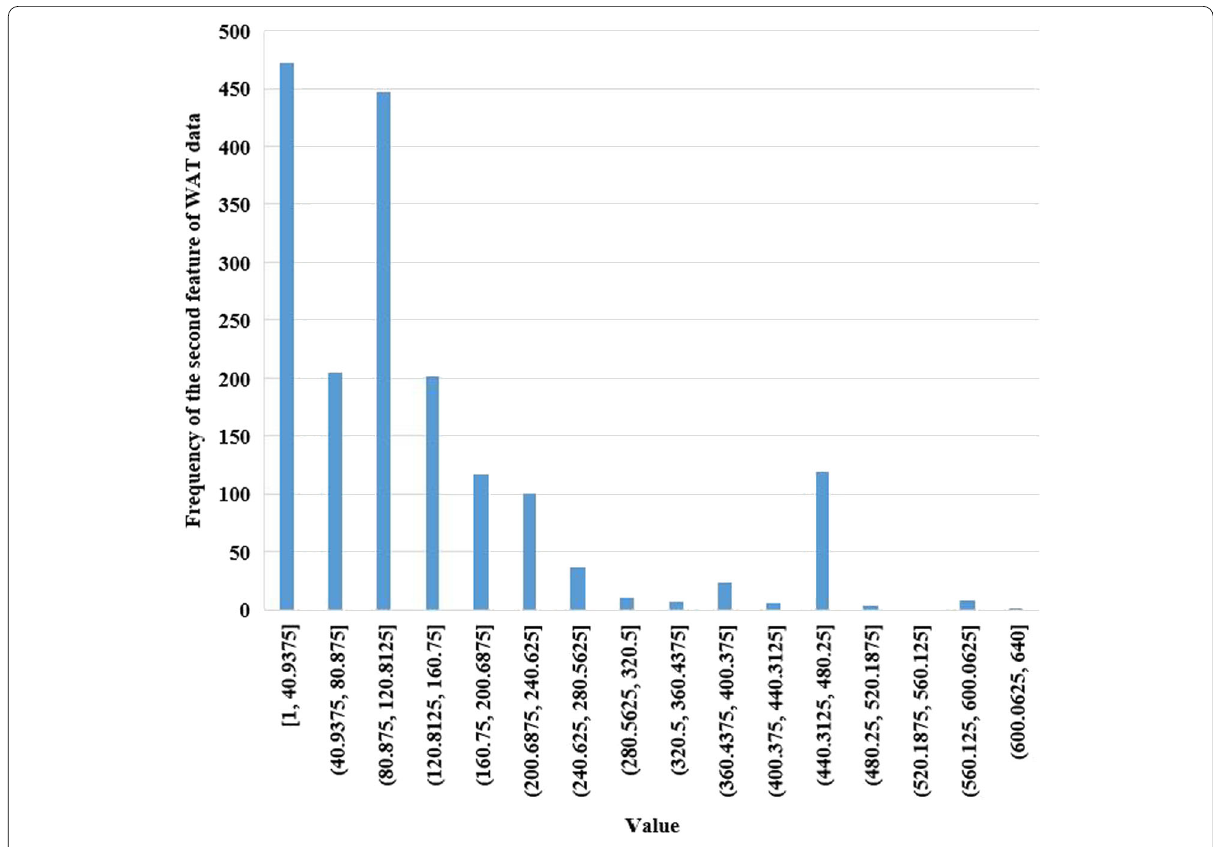
Figure 4 Second original feature data distribution of WAT